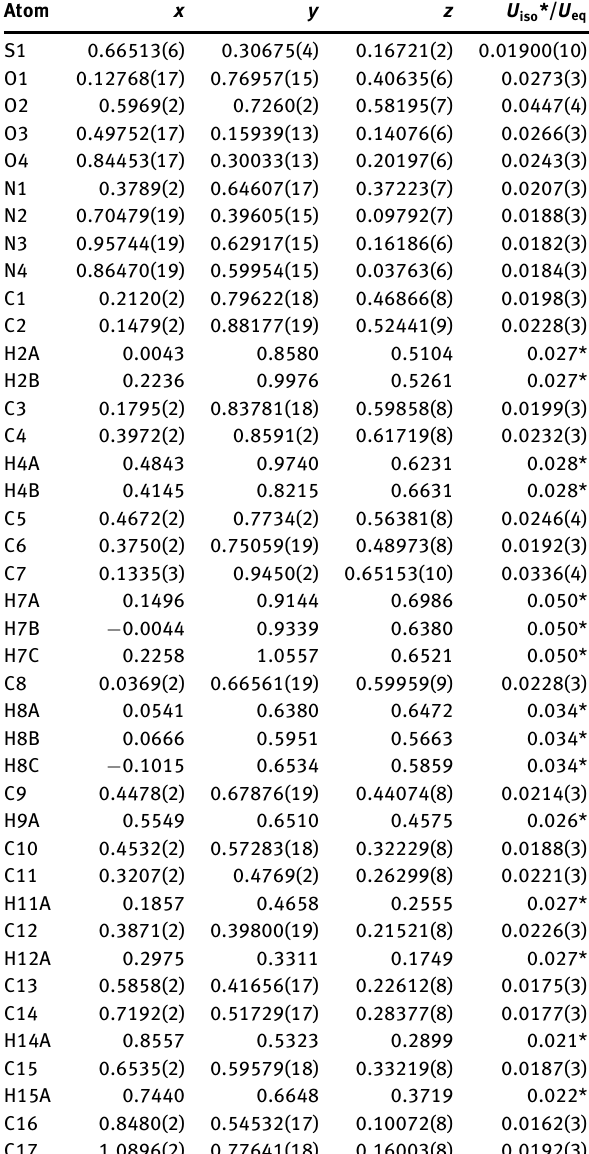
Table 2: Fractional atomic coordinates and isotropic or equivalent isotropic displacement parameters (Å 2